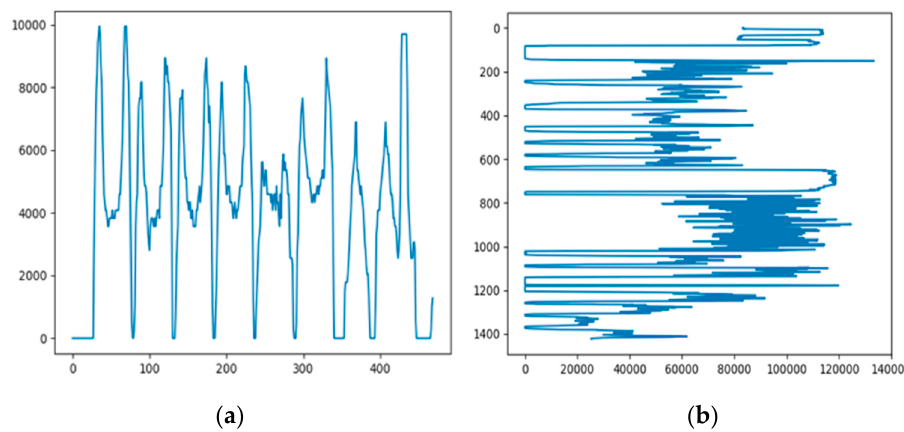
Figure 3. ( a ) Vertical projection of the receipt image ( b ) Horizontal projection of the receipt image .